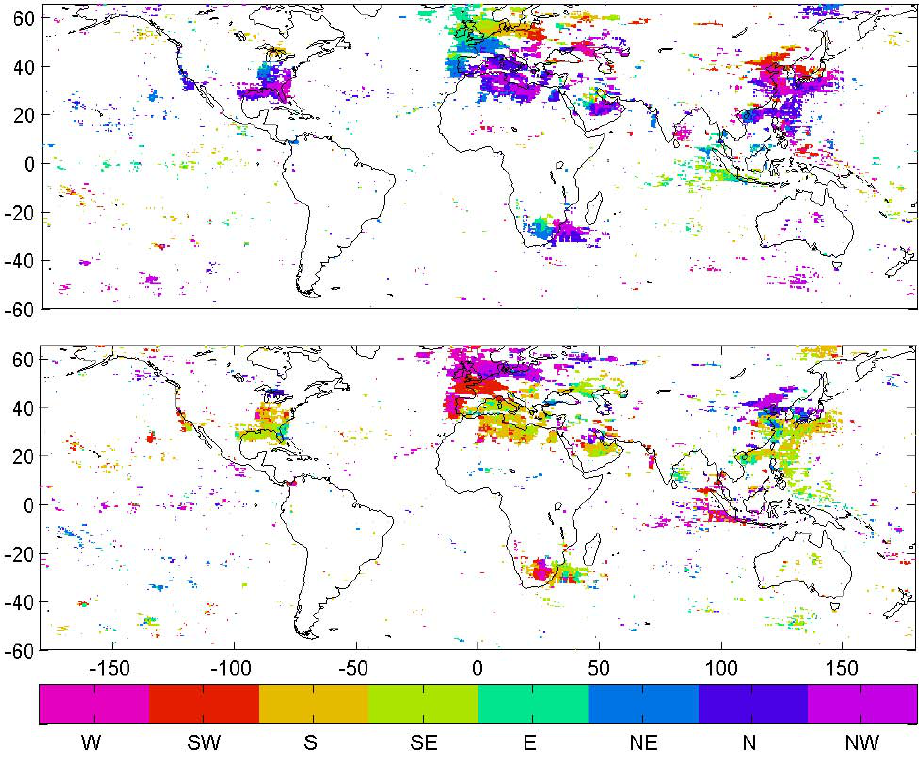
Fig. 7. Wind direction with (a) maximum and (b) minimum TVCD. Only data of p-values less than 0.001 are shown.